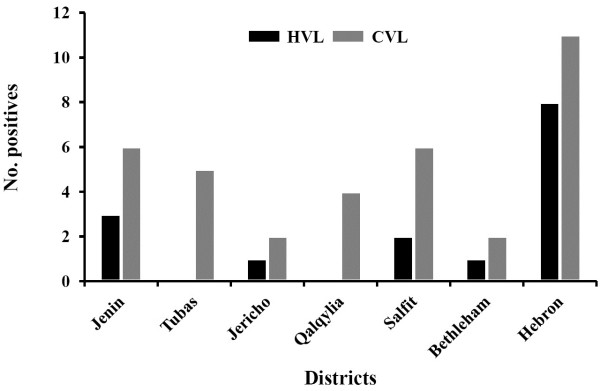
Bar graph of Human Visceral Leishmaniasis (HVL) as reported by Palestinian Ministry of Health compared to study results of canine Leishmania infection in the seven Palestinian districts.